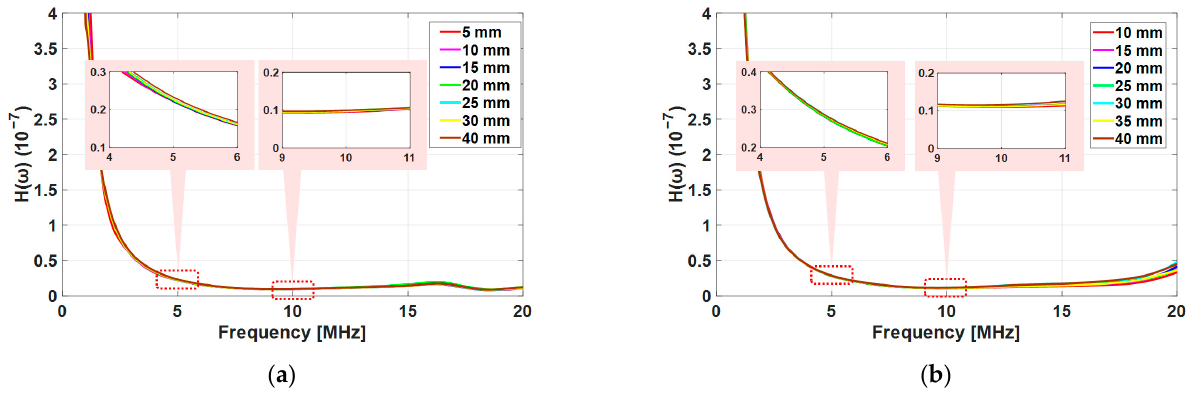
Figure 12. Transfer functions of the receiving transducer ( | H( ω ) | ) following from the calibration measurement after diffraction correction: ( a ) fused silica and ( b ) Al6061-T6.